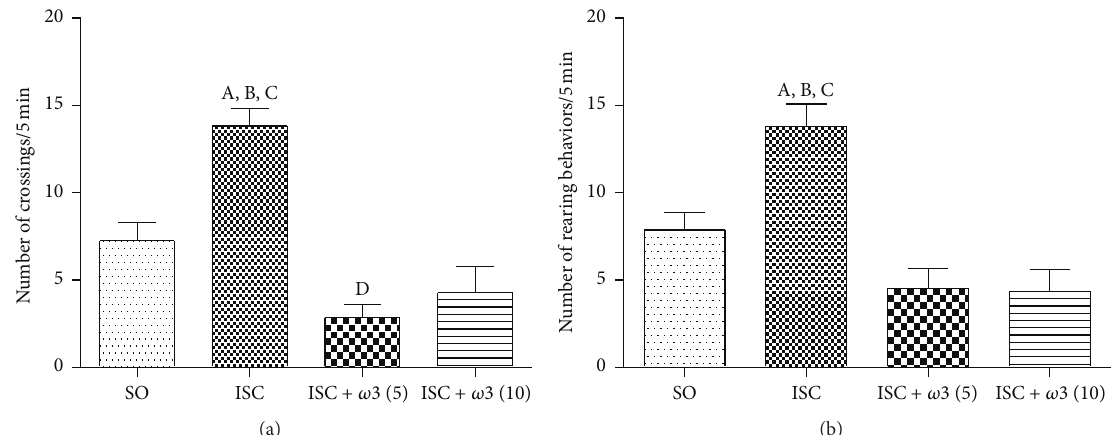
Figure 1: Evaluations of the number of crossing (a) and rearing (b) behaviors by the open field test. The columns represent means ± SEM (number of crossings/5min) from SO and rats subjected to cerebral ischemia untreated or after oral treatments with 𝜔 3, at the doses of 5 and 10mg/kg (number of animals per group: SO = 27; ISC = 35; ISC + 𝜔 3 (5) = 14; ISC + 𝜔 3 (10) = 17). (a) (A) versus SO, q = 6.591 ∗∗∗ ; (B) versus ISC + 𝜔 3 (5), q = 8.916 ∗∗∗ ; (C) versus ISC + 𝜔 3 (10), q = 8.288 ∗∗∗ ; (D) versus SO, q = 3.435 ∗ . (b) (A) versus SO, q = 5.533 ∗∗∗ ; (B) versus ISC + 𝜔 3 (5), q = 6.808 ∗∗∗ ; (C) versus ISC + 𝜔 3 (10), q = 7.246 ∗∗∗ (one-way ANOVA and Newman-Keuls test as the post hoc test).